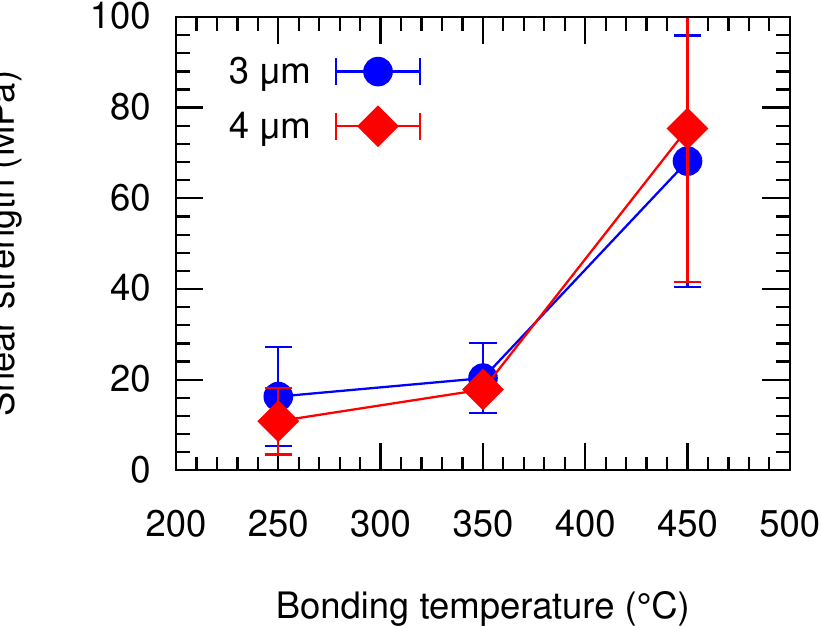
Figure 10. Dieshearstrengthofthebondedpackageswithrespecttothegroovesizeandbondingtemperature. At 450 ◦ C bonding temperature, the mean shear strengths were 68 MPa and 75 MPa for the specimens with 3 µm and 4 µm groove width, respectively. All the packages bonded at 450 ◦ C showed a shear strength of over 40 MPa. At the lower bonding temperature of 350 ◦ C, the mean shear strengths deteriorated to 20 MPa and 18 MPa, with 3 µm and 4 µm groove width, respectively. At the lower bonding temperature of 250 ◦ C, the figures further dropped to 16 MPa and 11 MPa for the devices with 3 µm and 4 µm groove width, respectively. The groove width difference did not significantly influence the bonding shear strength. On the other hand, the bonding strength of Al–Al diffusion bonding has been reported to deteriorate with the decreasing bonding temperature [18], which is in agreement with this study. The bonding strength has been associated with the quality of the atomic diffusion at the bonding interface [18]. In general, the die shear strength of the bonded packages is comparable to those of the established technologies where Al was employed as listed in Table 2. The fracture mode of the bonded packages is analyzed more in depth in the following